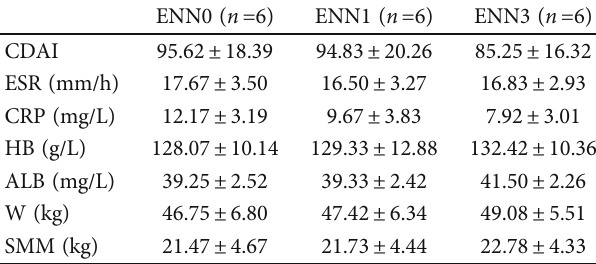
Table 3: Clinical outcome of EEN therapy in 0-month, 1-month, and 3-month